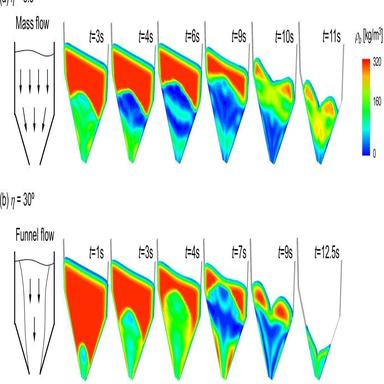
Predicted flow pattern with wall friction angle η = 8.5∘ (a), and with wall friction angle η = 30∘ (b).